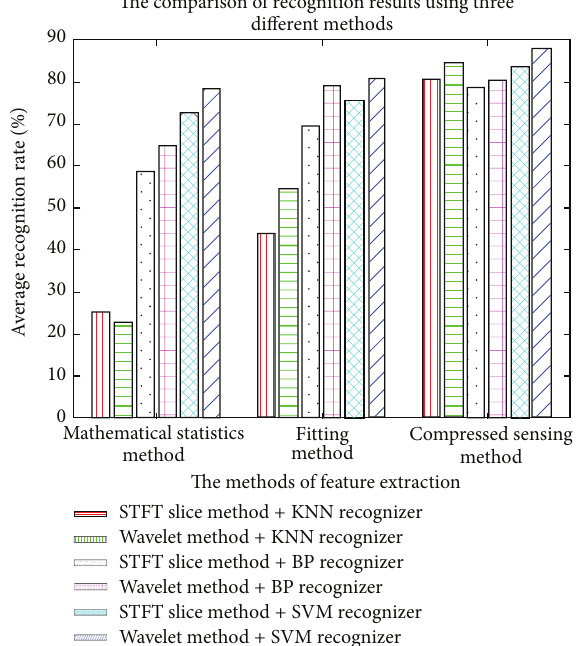
Figure 10: The comparison of classification results by three different